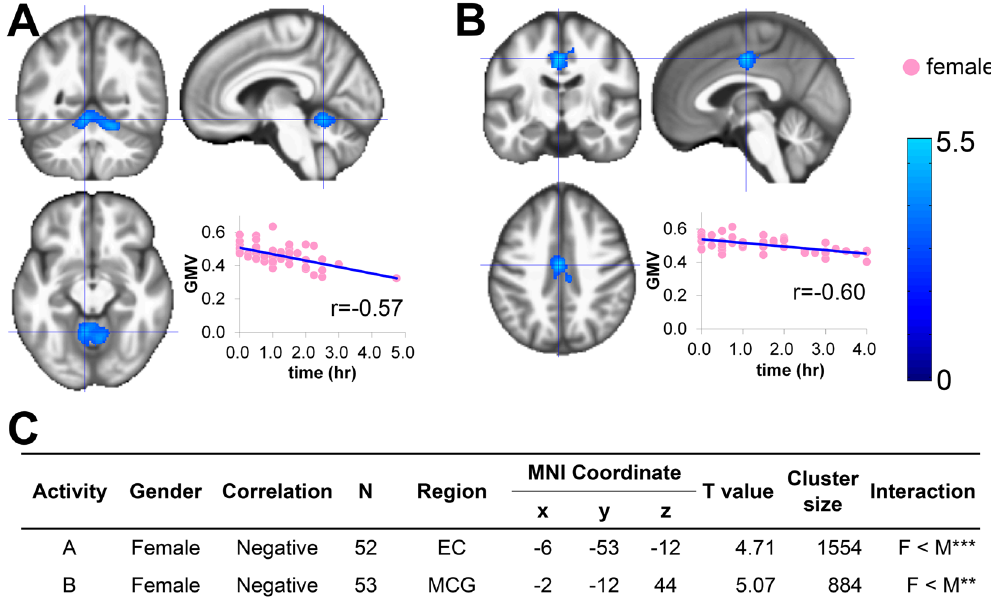
Figure 3. Sex-specific correlations between GMV and hours of sleep, rest, and relaxation. Regions that survived a statistical threshold of p < 0.05 (cluster-level corrected for multiple comparisons) are shown with ( A ) weekly range of daily time of Sleep in females, and ( B ) weekly range of daily time of Rest/relaxation in females. ( C ) Summary of the significant correlations. The X-axis of the scatter plot indicates the daily time or weekly range of activities. The Y-axis indicates the extracted GMV over the peak coordinates of the significant cluster. MNI, Montreal Neurological Institute; EC, exterior cerebellum; MCG, middle cingulate gyrus * p < 0.05, ** p < 0.01, *** p < 0.001.